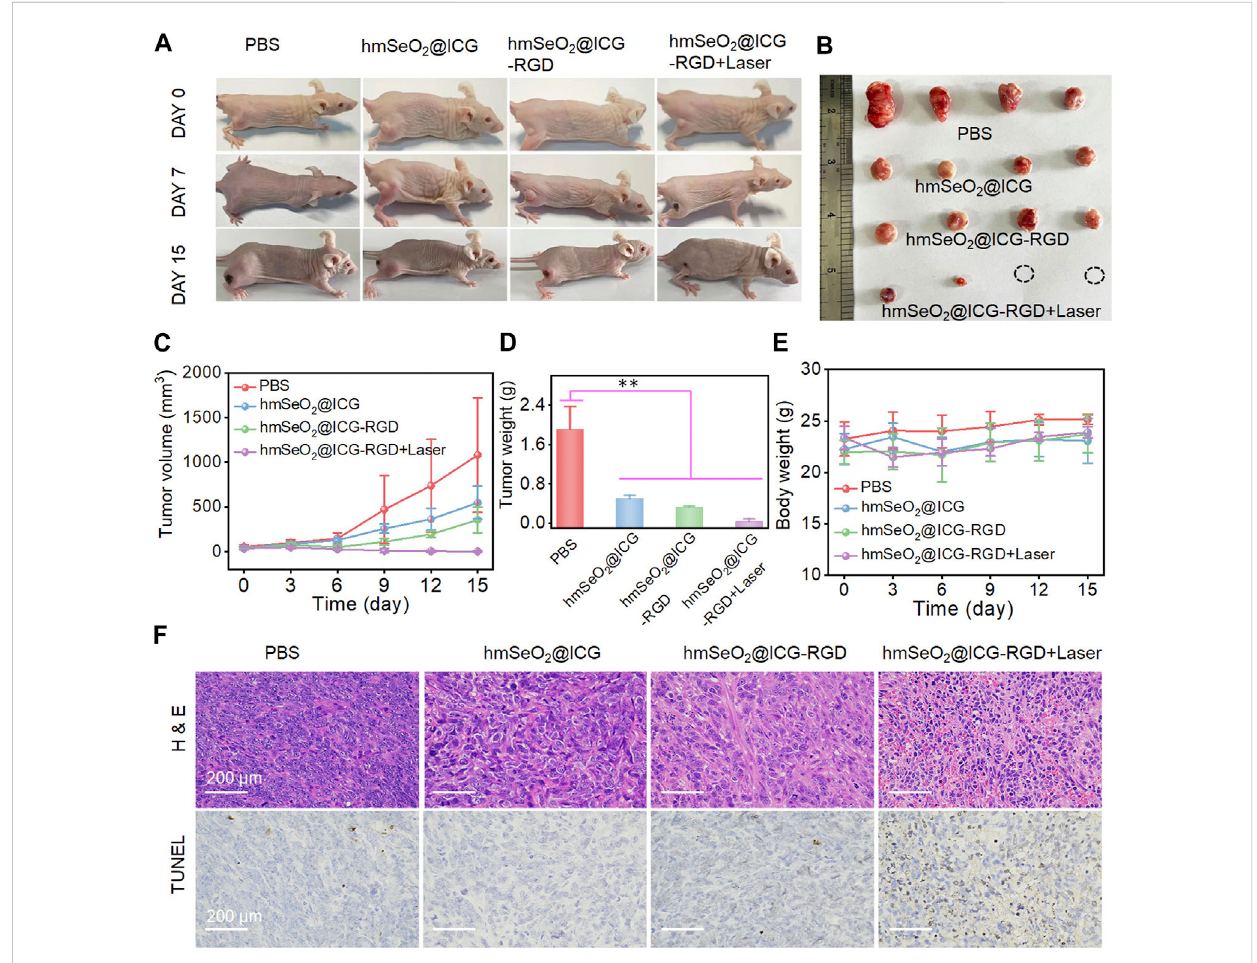
FIGURE 6 (A) Representative photographs of breast carcinoma-bearing BALB/c nude mice 0, 7 and 15 days after various treatments. (B) Representative resected tumors from mice in the various groups 15 days after treatment administration. (C) Tumor volumes in mice following various treatments. (D) Tumor weights after 15 days of treatment. ** p < 0.01. (E) Body weights of mice in each treatment group. (F) H&E and TUNEL-staining photographs of tumor tissues resected from subcutaneous tumor-bearing mice after various treatments for 7